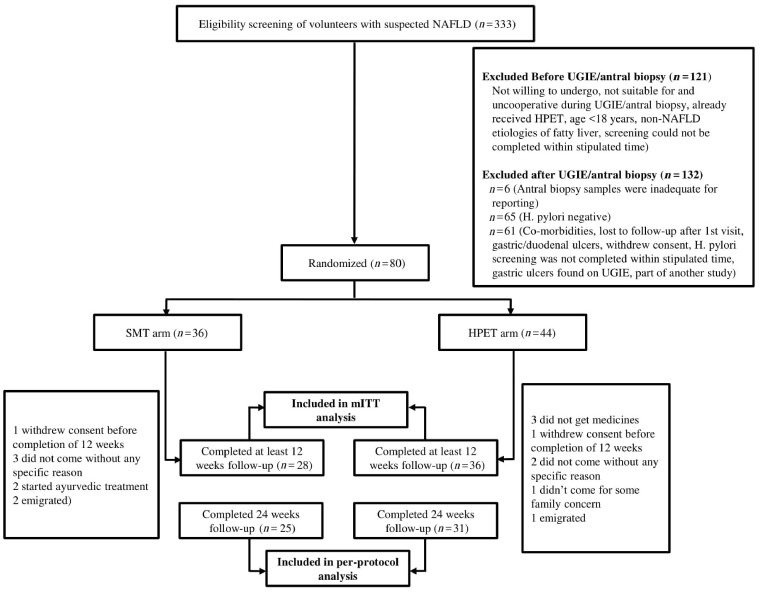
Consort chart showing the disposition of patients. UGIE, upper gastrointestinal endoscopy; NAFLD, non-alcoholic fatty liver disease; SMT, standard management therapy; HPET, H. pylori-eradication therapy; mITT, modified intention-to-treat.